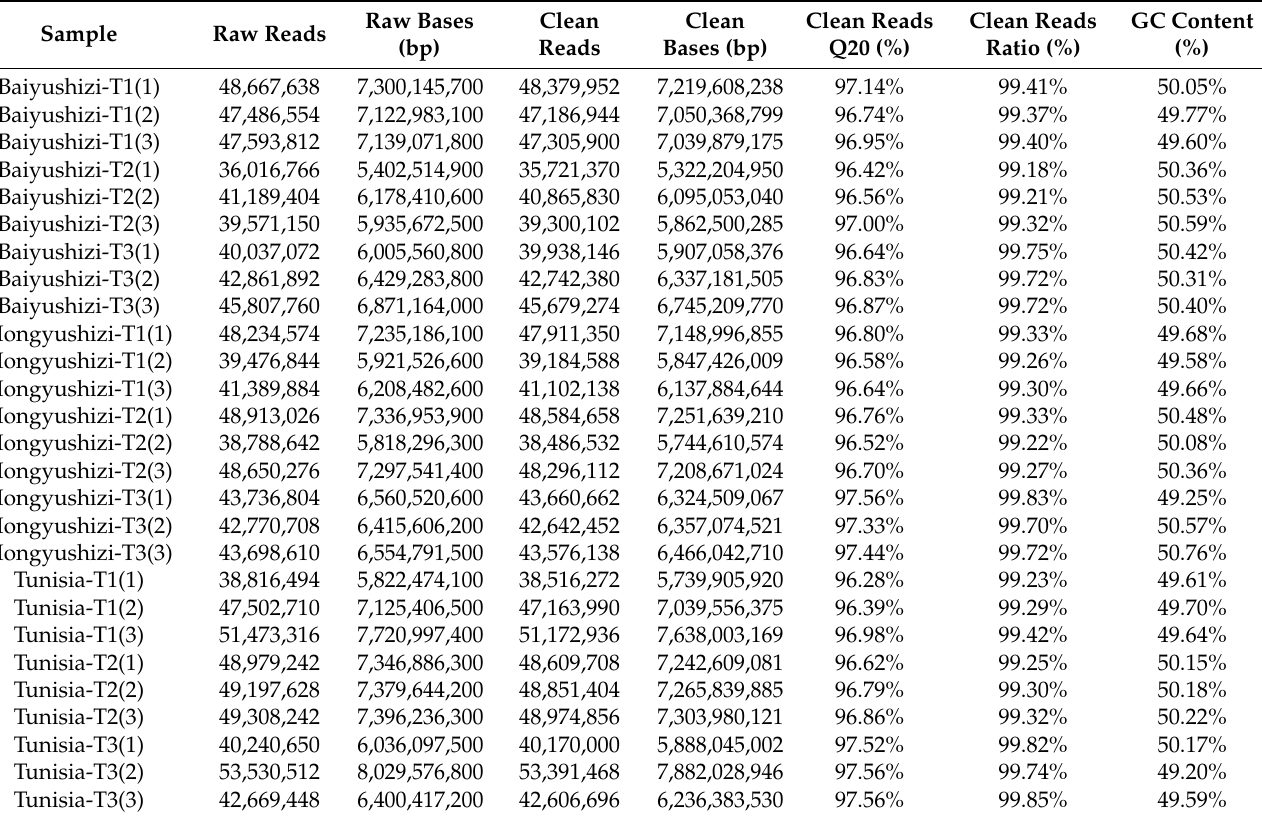
Table 4. Summary of RNA Sequencing Data, Clean Reads Q20—Sequencing base quality score > 20 and GC Content–GC ratio of sequence bases before